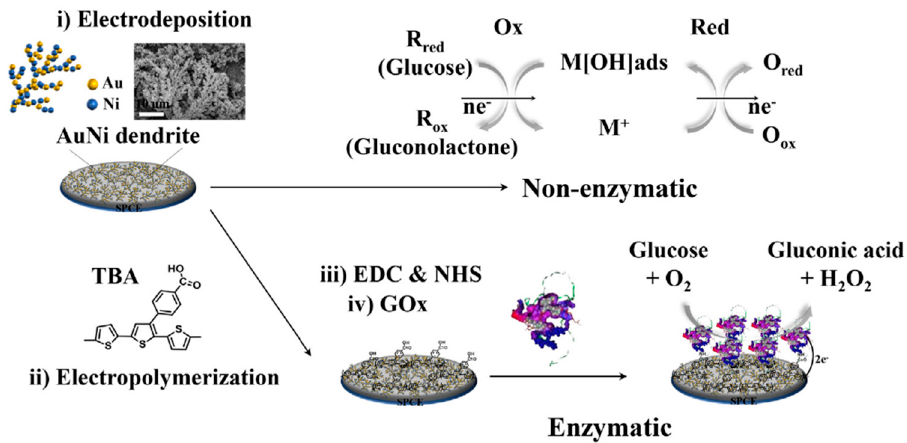
Figure 10. Scheme of the sensor fabrication and mechanism for glucose determination [94]. Copyright: Elsevier